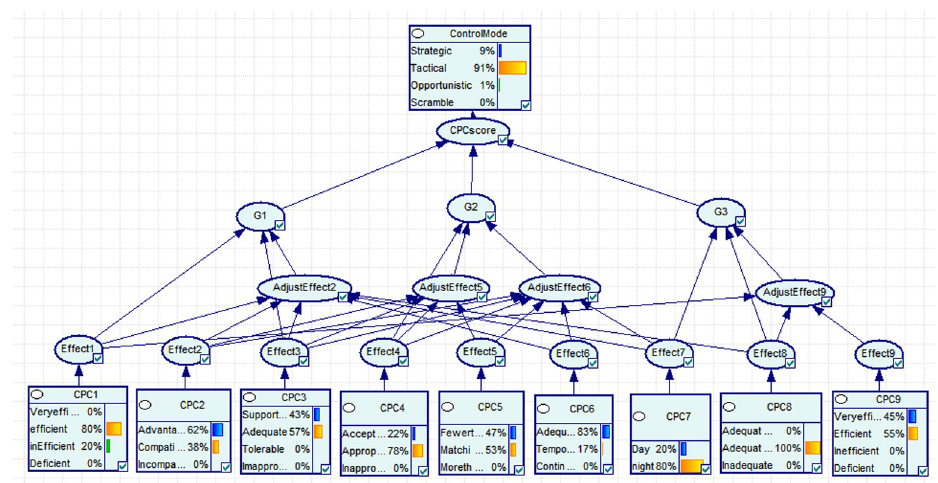
Fig 4. BN reasoning results for operation No.